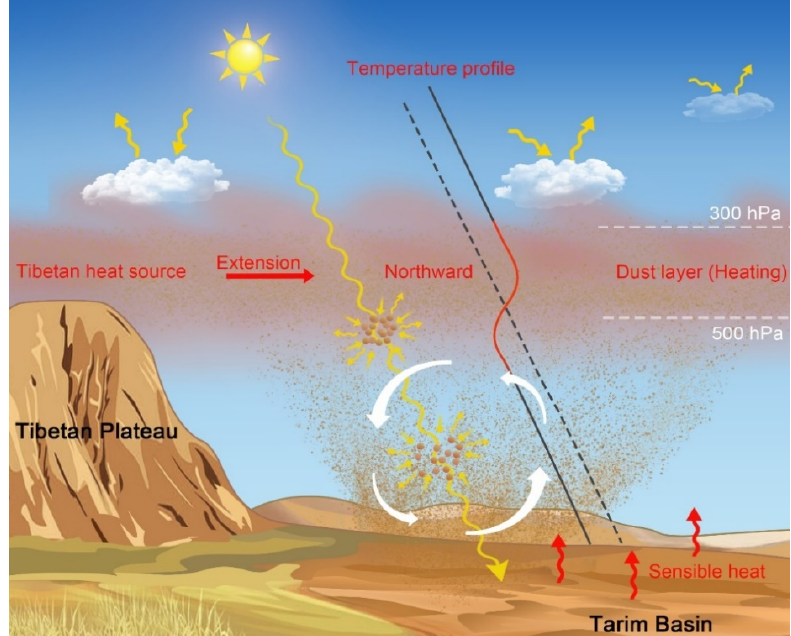
Figure 8. Conceptual scheme of the northward extension of the Tibetan heat source, which is partially attributed to the heating effect of suspended dust aerosols over the Tarim Basin. Solid and dashed lines represent the dust-influenced and dust-free temperature profiles, respectively. Yellow arrows denote solar radiation, including the components reflected and absorbed by clouds, dust aerosols, and the surface. Red arrows at the surface denote sensible heat. White solid arrows denote turbulent and convective mixing in the planetary boundary layer. White dashed lines indicate the